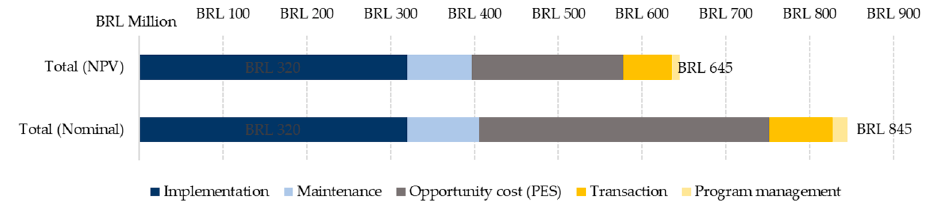
Figure 3. NbS scenario full lifecycle (35-year) costs in nominal and NPV terms.